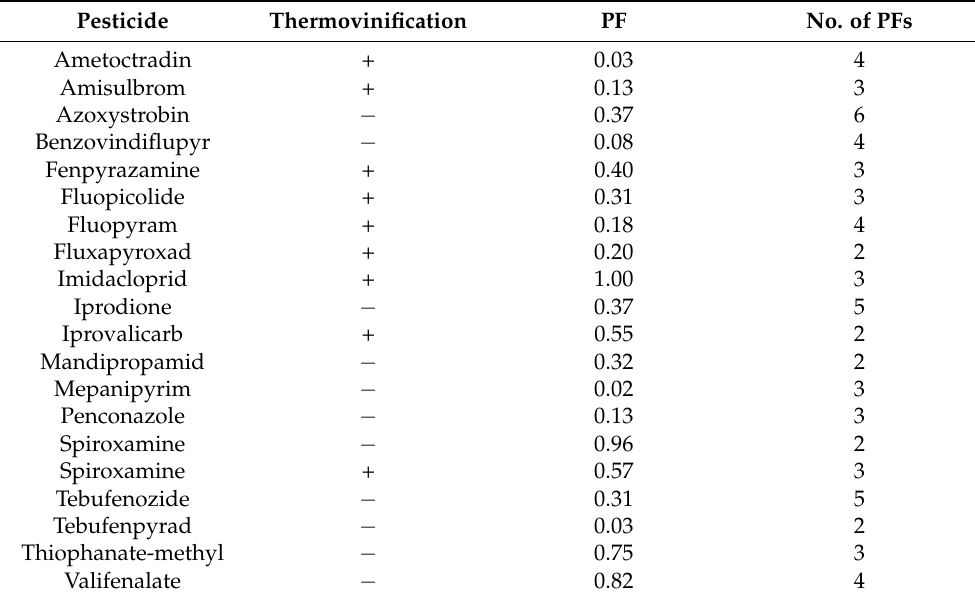
Table 3. Median processing factor (PF) for different pesticides in red wine produced with (+) and without ( − ) thermovinification.